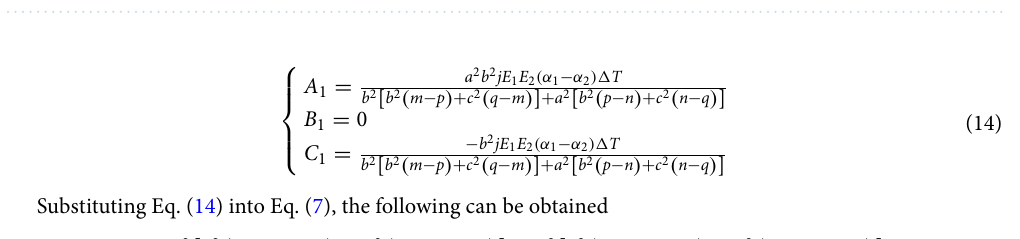
Figure 7. Two types of NTE